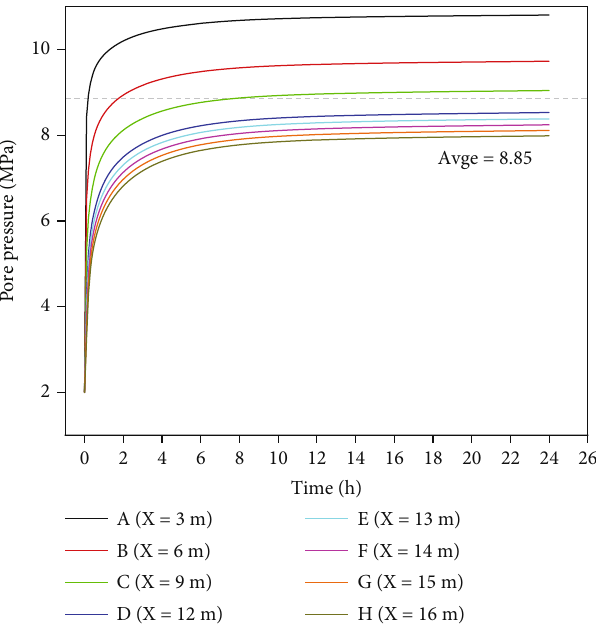
of each detection point. CH 4